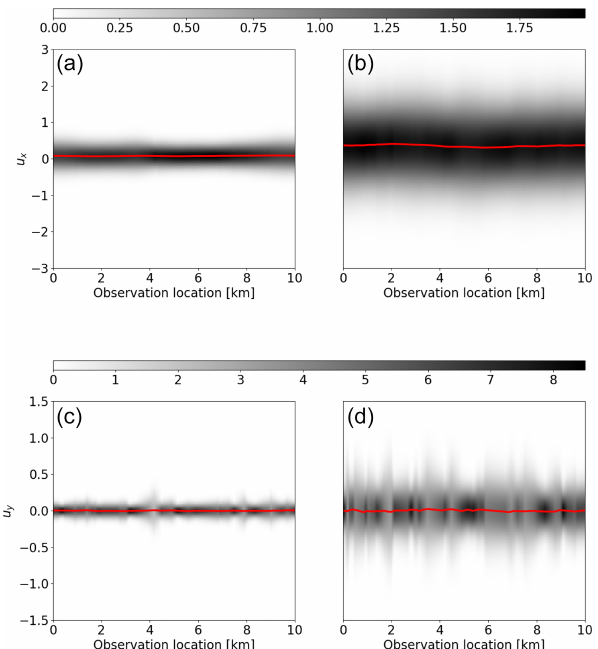
Figure 8. Second order statistics of the approximation errors for Example 2. (a, b) Distribution of the approximation errors in the x direction velocity measurements for Example 2a (a) and 2b (b) . (c, d) Distribution of the approximation errors in the y direction velocity measurements for Example 2a (c) and 2b (d) . The mean of the approximation errors, ε ∗ , is indicated with a red line, while higher probability density is indicated by darker shading.